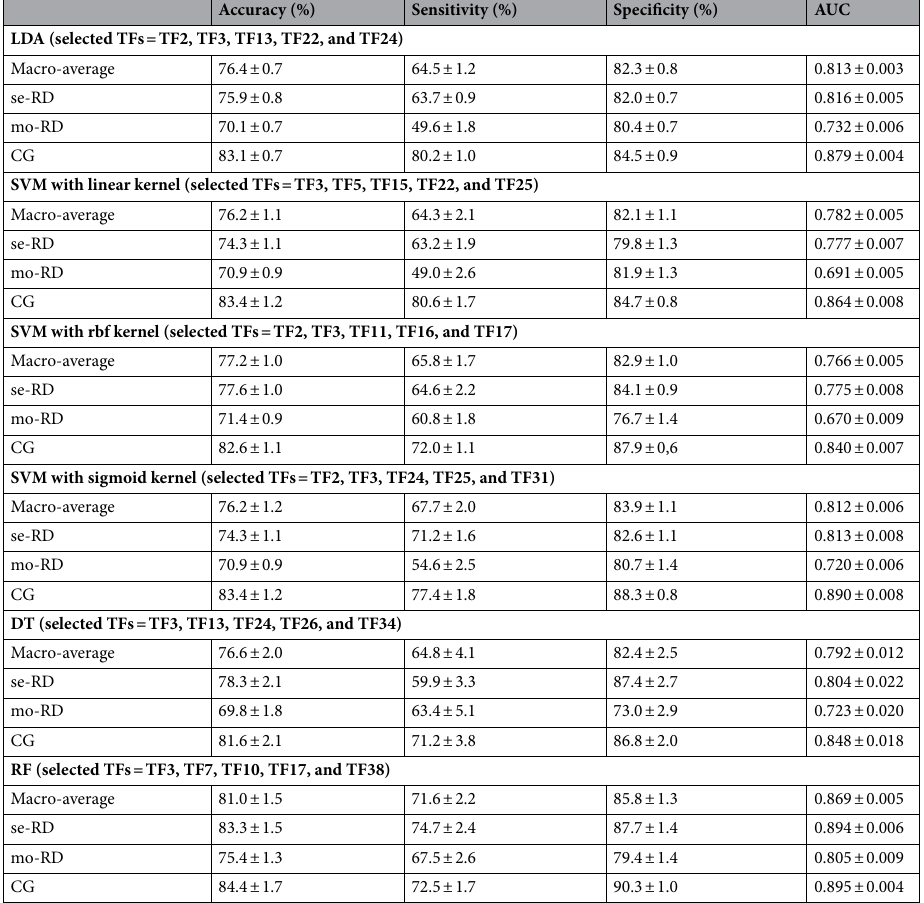
Table 4. Performance of each classification attempt in discriminating between the three groups in T1-weighted opposed-phase imaging (T1WI OP). TF texture feature, DT decision tree, LDA linear discriminant analysis, SVM support vector machine, RF random forest classifier, AUC area under the curve, se-RD severe renal dysfunction (estimated glomerular filtration rate [eGFR] < 30 mL/min/1.73 m 2 ,